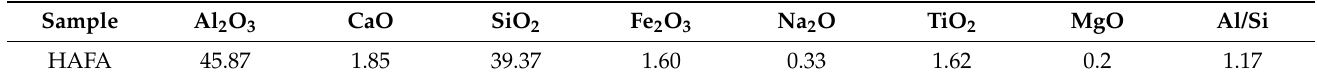
Table 1. Chemical composition of original HAFA (wt.%).